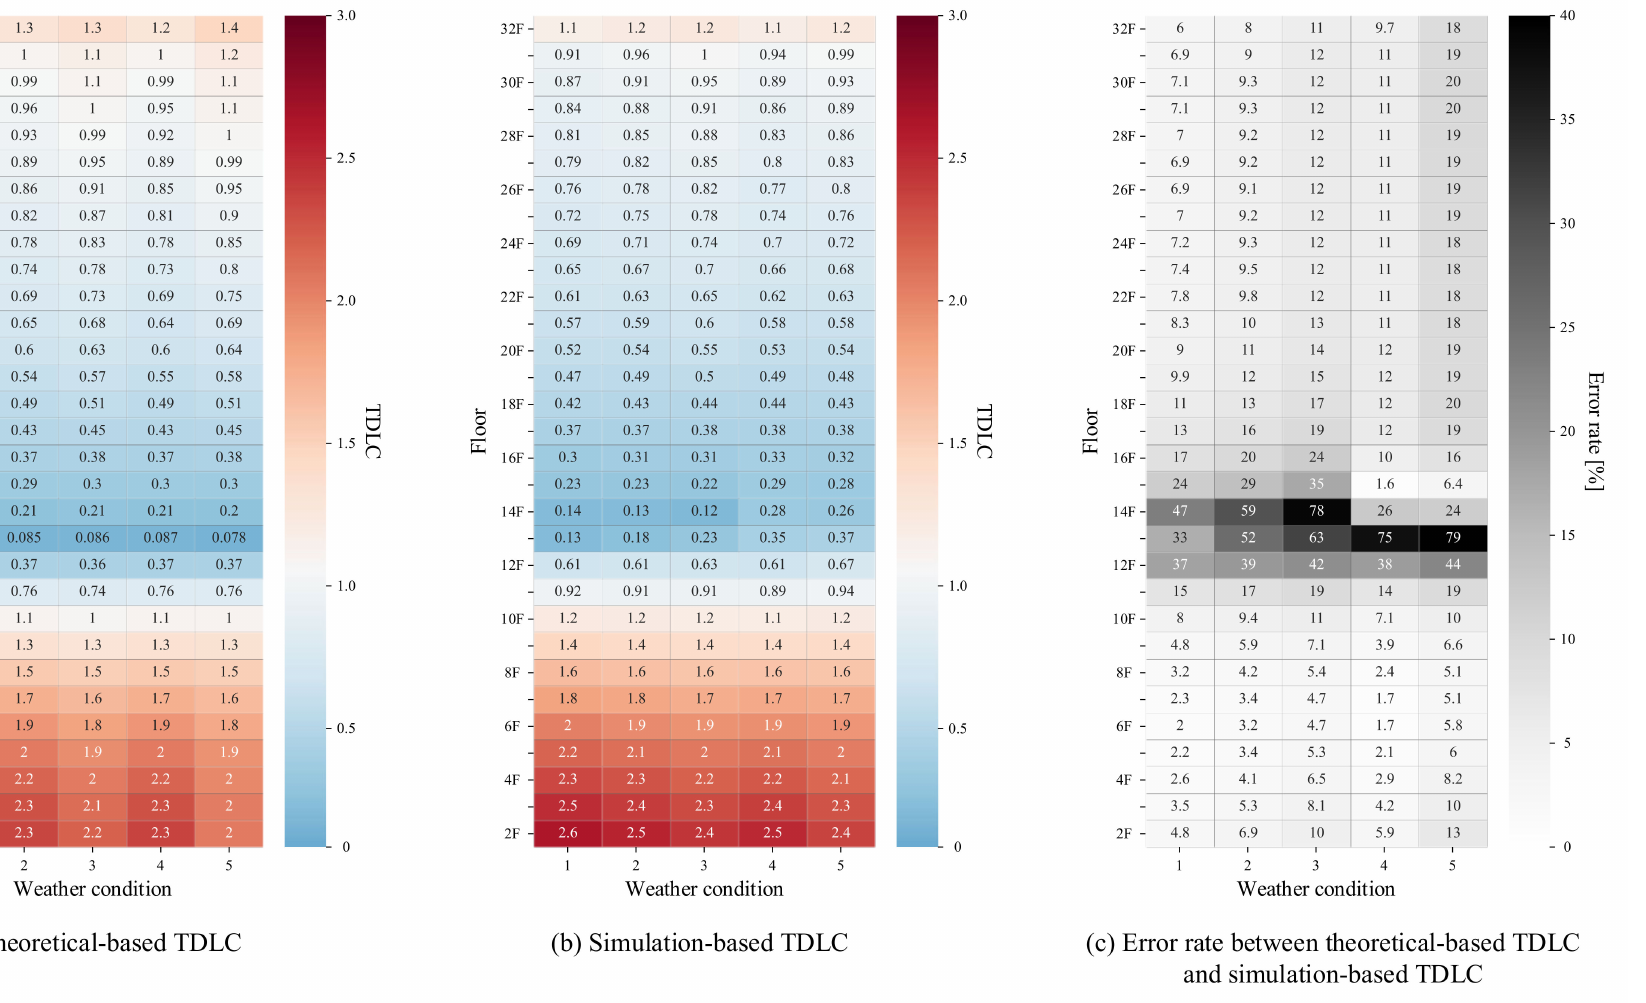
Figure 7. The TDLC (Thermal Draft Load Coefficient) and its error rate by clustered weather